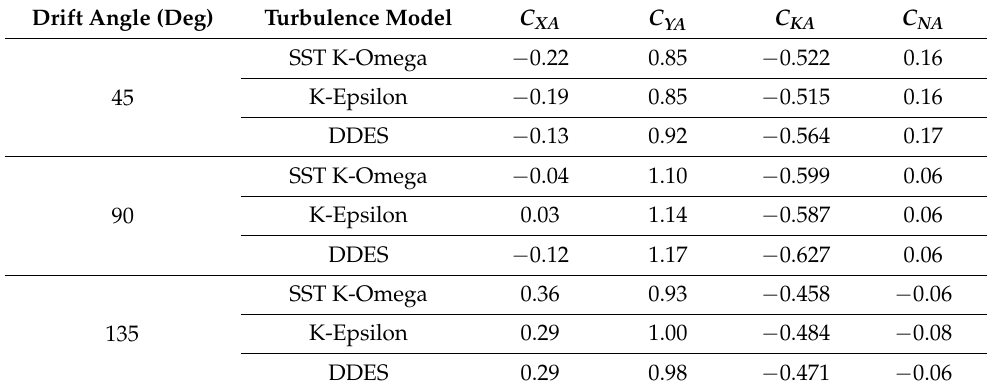
Table 1. The surge and sway force and heel and yaw moment results for the aerodynamic load- predicted using model scale simulations in OpenFOAM. Drift Angle (Deg) Turbulence Model C XA C YA C